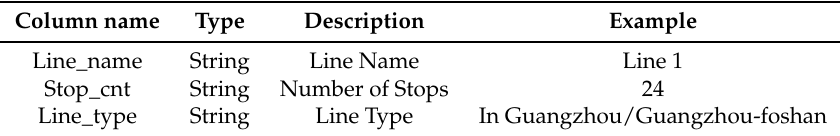
Table A2. Bus route information table.